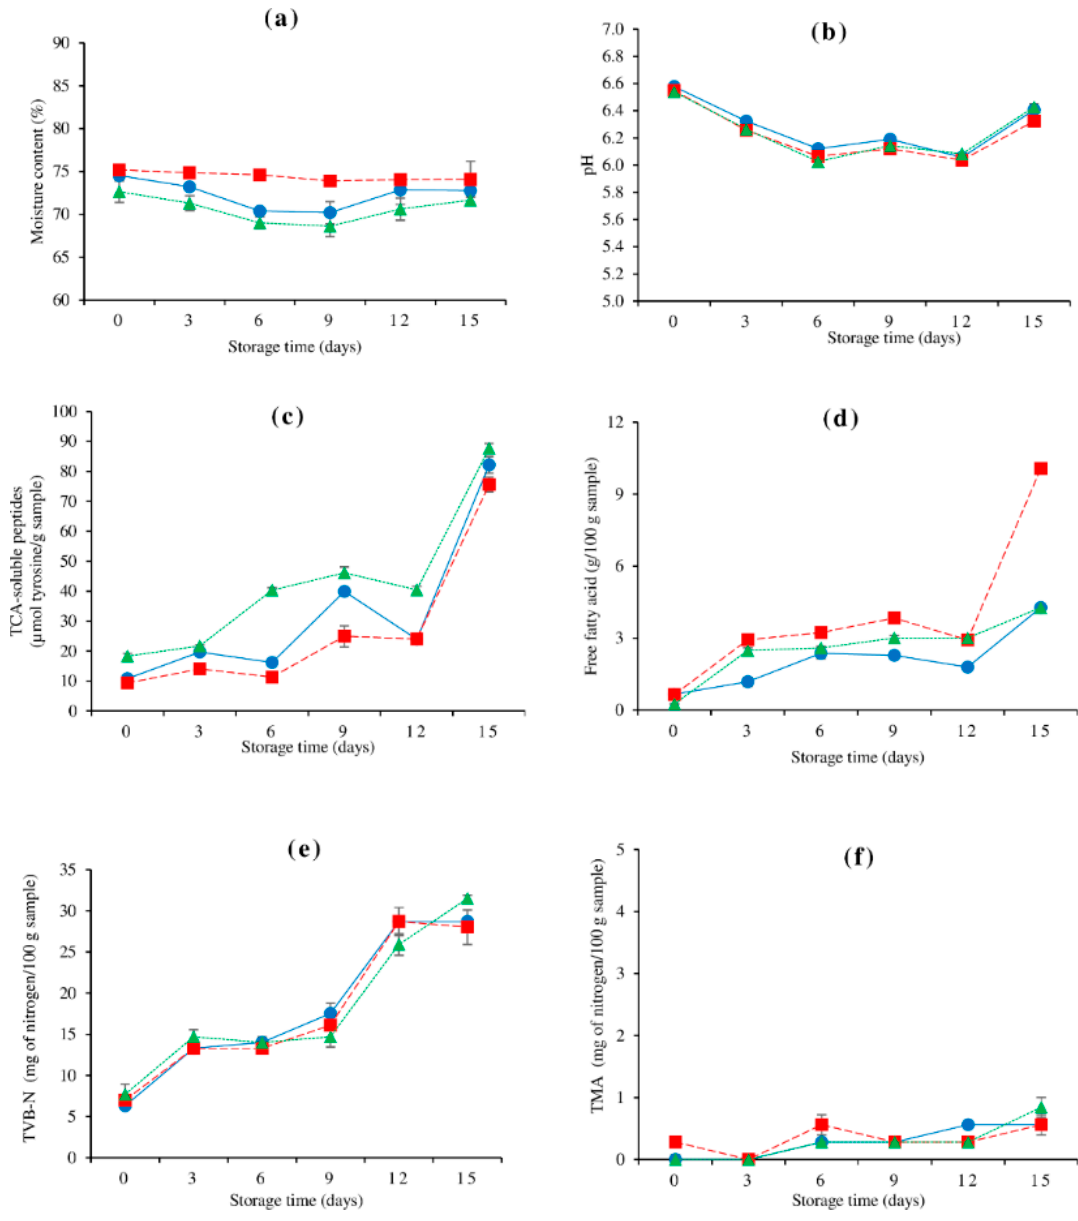
Figure 1. Changes in moisture content ( a ), pH ( b ), TCA-soluble peptide ( c ), free fatty acid ( d ), total volatile base-nitrogen (TVB-N) ( e ), and trimethylamine (TMA) ( f ) of farmed hybrid catfish dorsal muscle (— • —), lateral line (— (cid:4) —), and ventral muscle ( · · · (cid:78) · · · ) during 15 days of refrigerated storage. The bars indicate standard deviation from triplicate